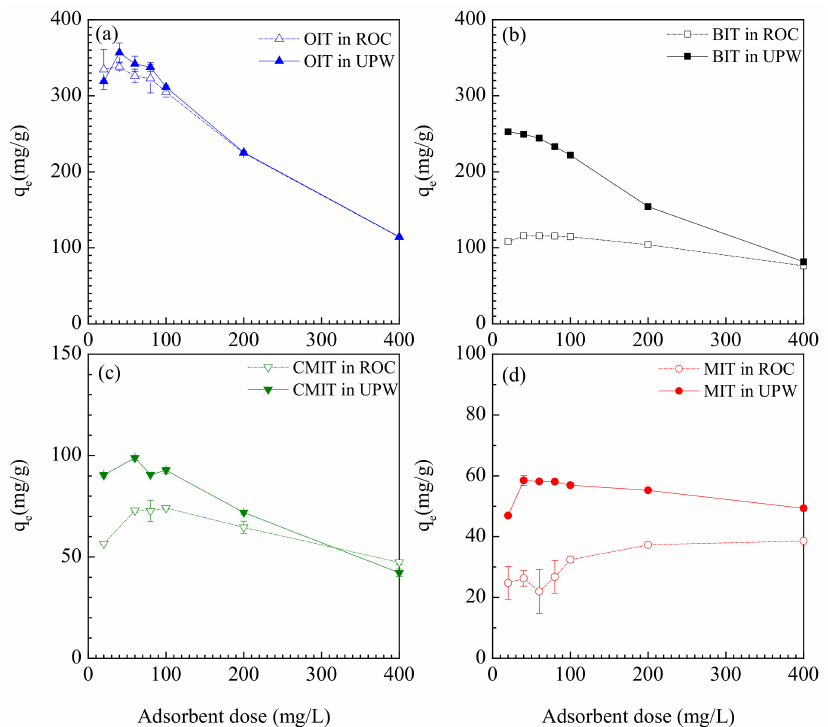
Figure 6. Effects of textile reverse osmosis concentrate on the amount of isothiazolones adsorbed. OIT ( a ), BIT ( b ), CMIT ( c ) and MIT ( d ). Note: ROC, reverse osmosis concentrate; UPW, ultra-pure